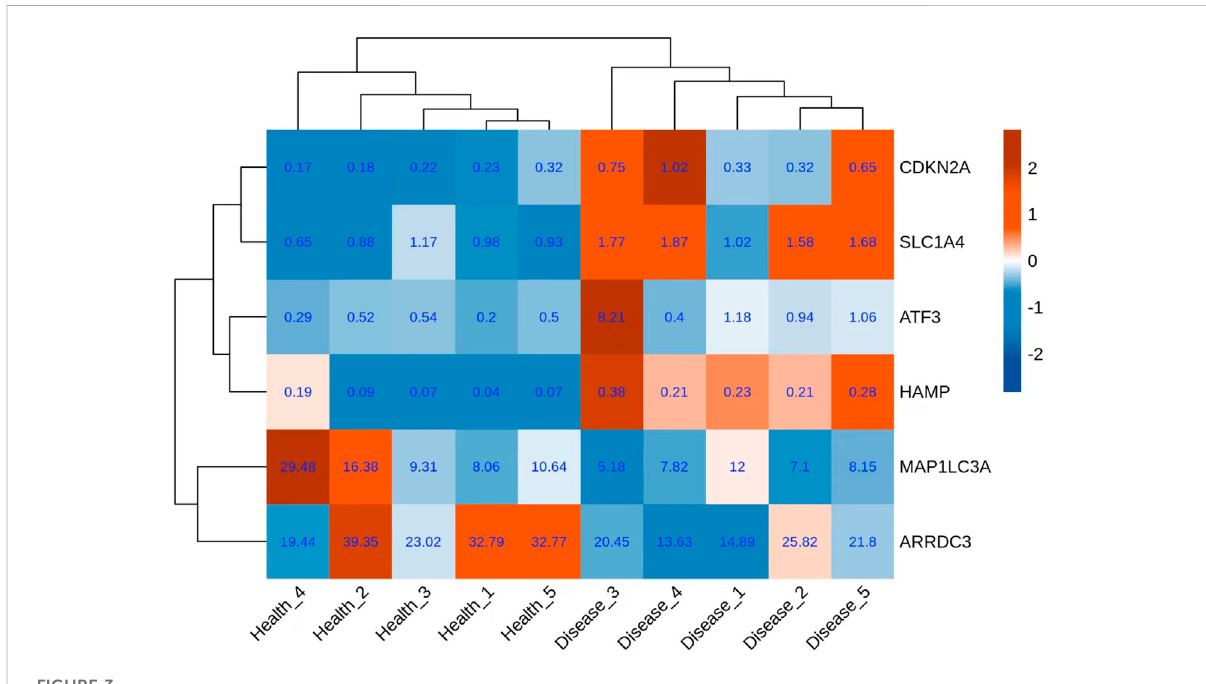
FIGURE 3 Expression of differential genes associated with